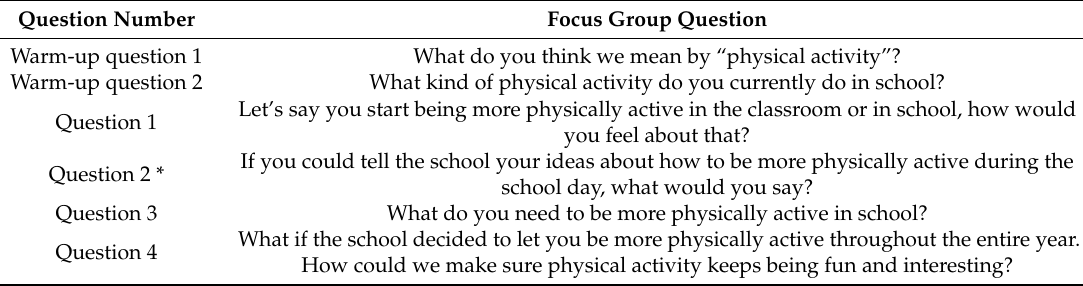
Table 1. Semi-structured focus group discussion